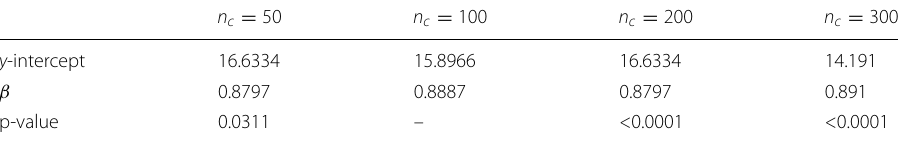
Table 7 Comparison of y ‑intercepts and β s for the regression of purchases4D ∼ intention4D for several values of n c . The p‑value of the results of an Anova test comparing the different β for n c = 50,200 and 300 against that of n c = 100 are shown. The hypothesis of different values of β can be rejected with 95% confidence n c =